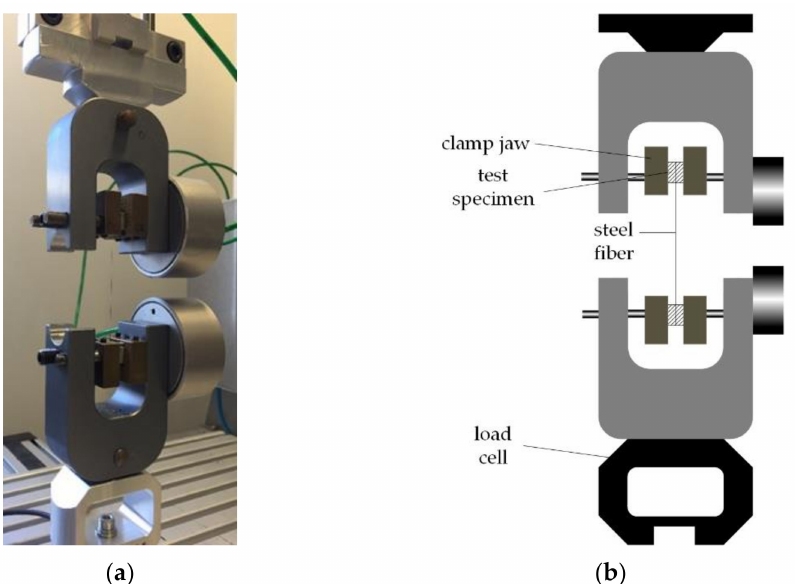
Figure 1. Test setup for pull-out tests: ( a ) Physical; ( b ) Schematic [15]. Reproduced from the Proceedings of the fib Symposium 2019: Concrete Innovations in Materials, Design and Structures, paper “Pull-Out tests of carbon and high-strength steel microfibres in a cement-based matrix”, page 1893 -” Figure 5: Tests set-up for pull-out tests, left: for carbon fibre, middle and right: for steel fibre” with permission from the International Federation for Structural Concrete